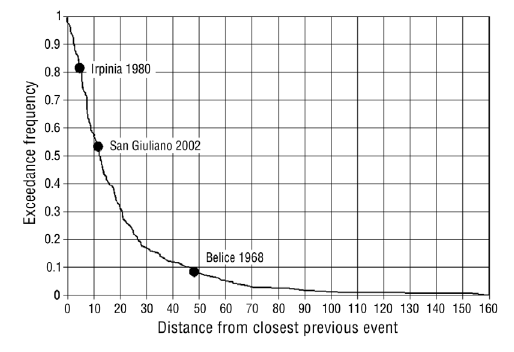
Fig. 4. CPND cumulative exceedance frequency (from 1600 to the present).